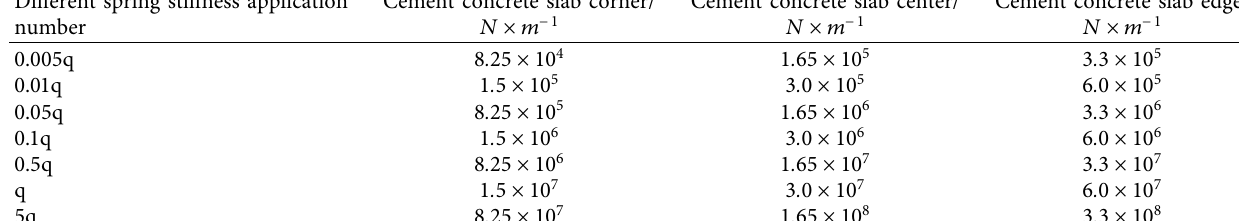
Table 7: Spring stiffness at different points of the